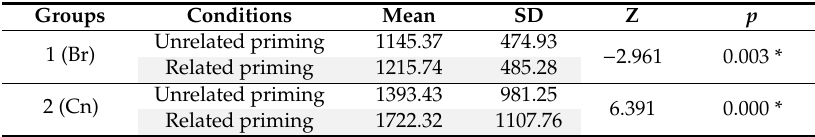
Results from the comparison of reaction times (RTs) regarding the processing of grapho(-phonic)-phonologically related and unrelated primed items by both